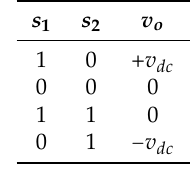
Table 1. Admissible states for H-Bridge